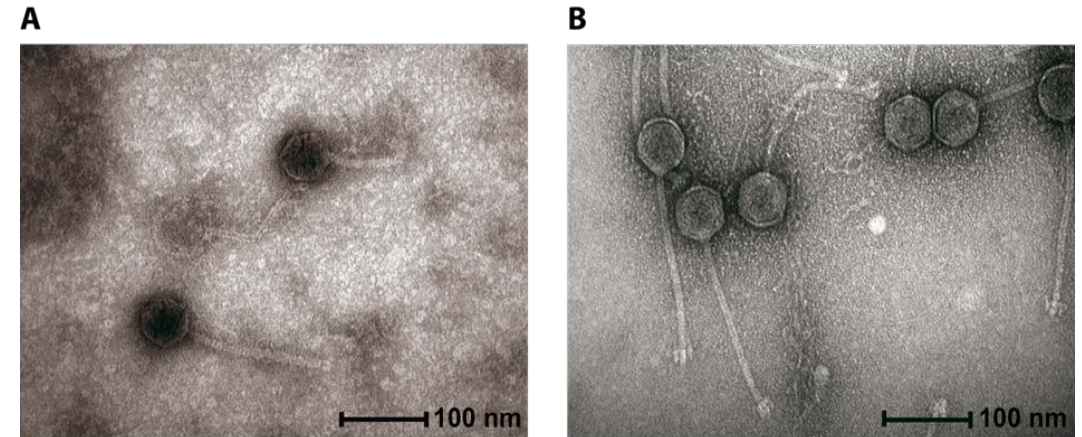
Figure 1. Transmission electron microscopy (TEM) images of Streptococcus phages 23TH ( A ) and SA01 ( B ).